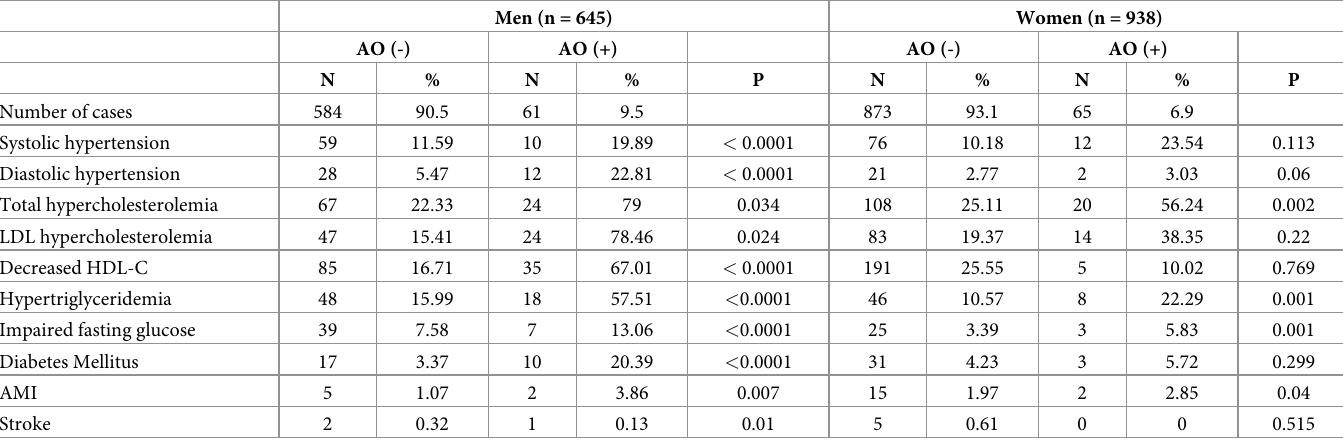
Table 3. Frequency of CVRF, AMI and stroke in normal weight individuals (BMI:18.5–24.99 kg/m 2 ) with